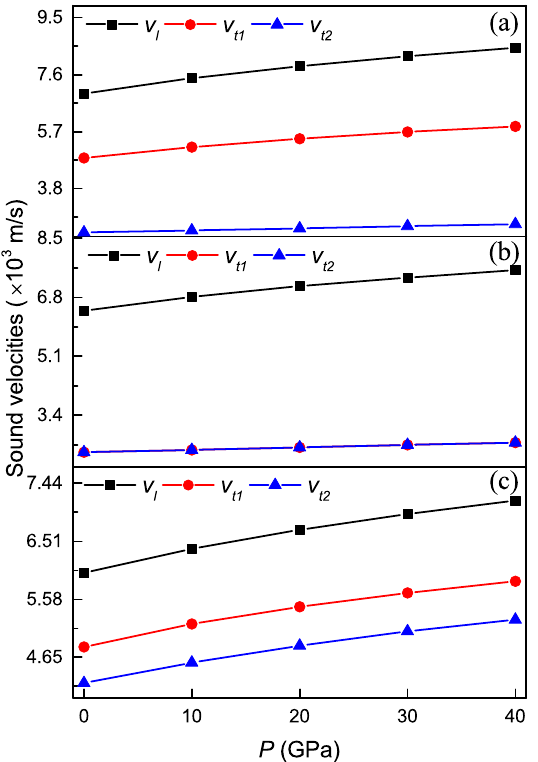
Figure 9. Longitudinal and transverse sound velocities in [100] ( a ), [001] ( b ) and [110] ( c ) directions as a function of pressure for the Ti 4 Nb 3 Al 9